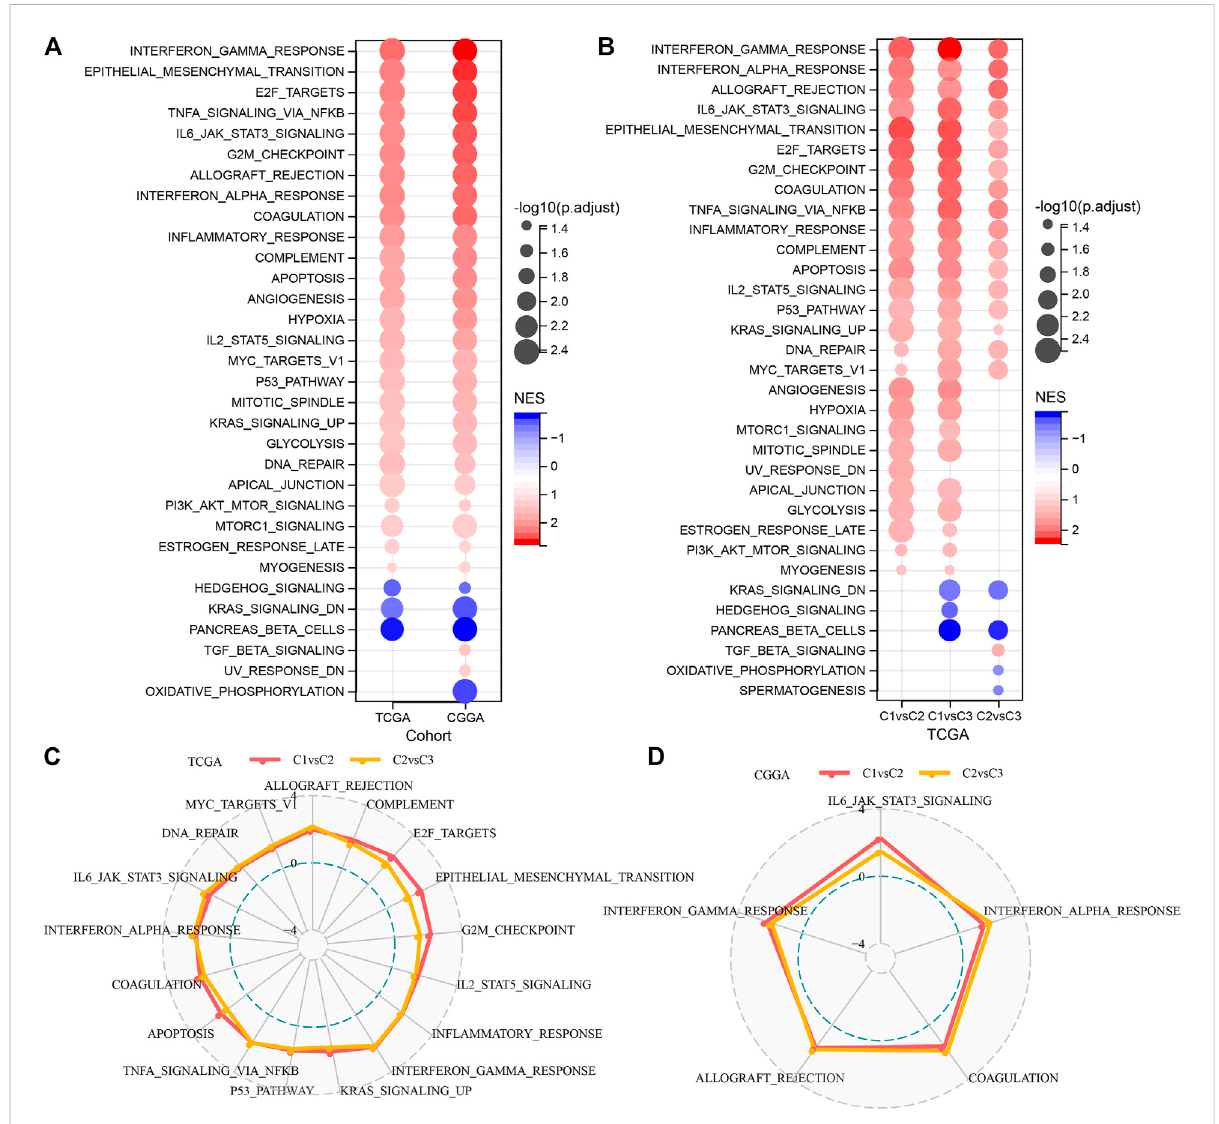
FIGURE 4 Signi fi cantly activated pathways in various molecular subtypes (A) Bubble chart of GSEA results for C1 vs. C3 subtypes in two LGG cohorts. (B) Bubble chart of GSEA results for various molecular subtypes comparedin the TCGA-LGG cohort. (C) Radar chart of C1 vs. C2, C2 vs. C3 consistently activated pathways in the TCGA-LGG dataset. (D) Radar chart of C1vsC2, and C2vsC3 consistent activation pathways in the CGGA